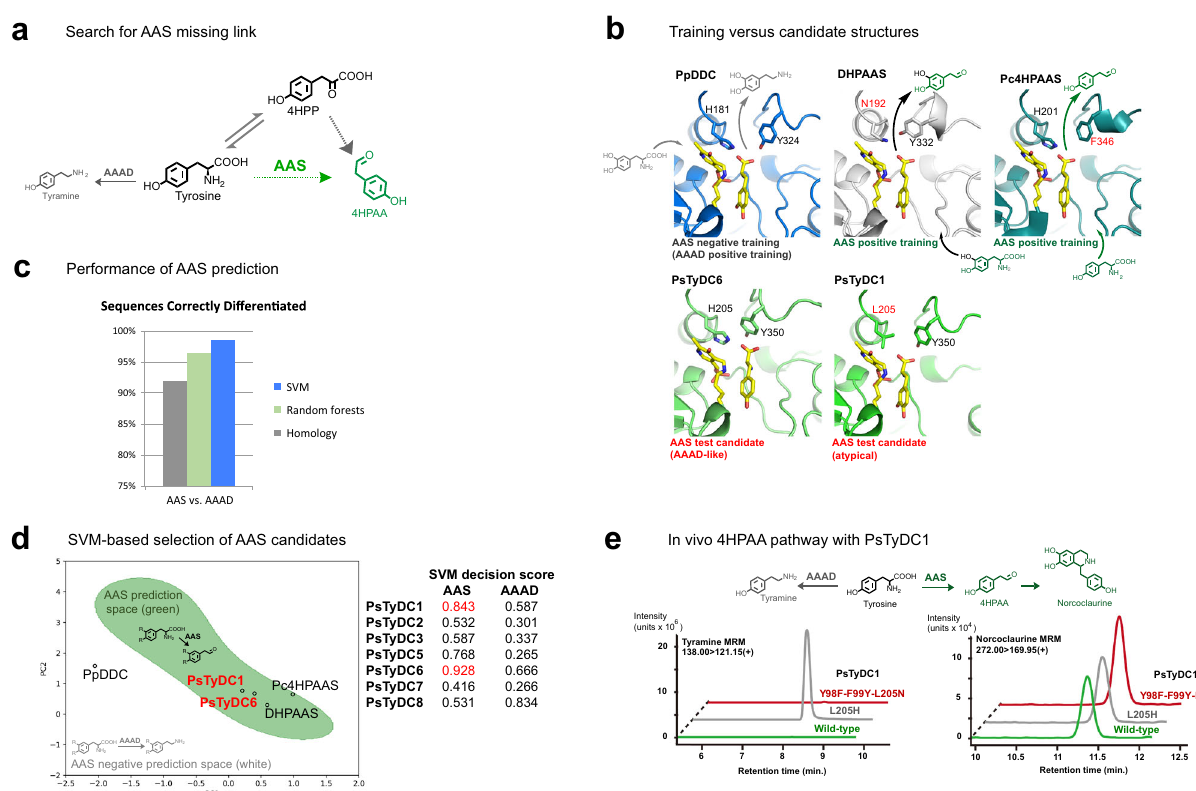
Fig. 2 Prediction of AAS branch pathway enzymes to produce 4HPAA for norcoclaurine production. a The aromatic acetaldehyde synthase (AAS) branch pathway (green) can produce 4HPAA directly from tyrosine, but this missing link is unreported in P. somniferum . b Structure-based curation of typical aromatic amino acid decarboxylase (AAAD), insect-type AAS and plant-type AAS, as represented by the active site con fi gurations of Pseudomonas putida DDC (PpDDC, blue), Bombyx mori DHPAAS (DHPAAS, grey), and Petroselinum crispum 4HPAAS (Pc4HPAAS, deepteal). AAS candidate PsTyDC1 (green) has a unique active site, while AAS candidate PsTyDC6 (green) has an AAAD-like active site and could not be predicted by a homology or structure-based approach alone. c Cross-validation for correct assignment of AAAD and AAS training sequences is performed using SVM models (blue), Random forests models (green), and by comparing sequence homology of each training sequence to a consensus sequence of AAS training sequences and a consensus sequence of AAAD training sequences (grey), as described in the methods section. d For visual representation, a two-dimensional plot of AAS SVM-based prediction is shown, with positive and negative prediction spaces colored green and white, respectively (left side). Principal component analysis (PCA) is used to compress multi- dimensional data into two dimensions (PC1 and PC2) for a visual representation. Corresponding high-dimensional SVM decision scores from Supplementary Table 1 are shown on the right. Decision scores represent the distance from the SVM prediction boundary. PsTyDC1 and PsTyDC6 score highest for AAS prediction and are colored red. e LC-MS detection of products from Thalictrum fl avum norcoclaurine synthase (TfNCS) containing strains T1-01-DE3 (wild-type PsTyDC1 + TfNCS), T1-02-DE3 (PsTyDC1-L205H + TfNCS) and T1-03-DE3 (PsTyDC1-Y98F-F99Y-L205N + TfNCS) (Supplementary Table 2), grown in LB supplemented with 1mM tyrosine and 0.5mM dopamine, at 28°C with 180rpm shaking for 51h. Selective in vivo production of the downstream AAS product norcoclaurine accompanies the expression of wild-type PsTyDC1 (green), as well as the triple variant of PsTyDC1 with an engineered active site based on that of insect DHPAAS (red). Tyramine is the major product of PsTyDC1-L205H (grey), which contains an engineered active site based on typical AAAD. Similar results are replicated in Supplementary Fig. 2 and Supplementary Fig.